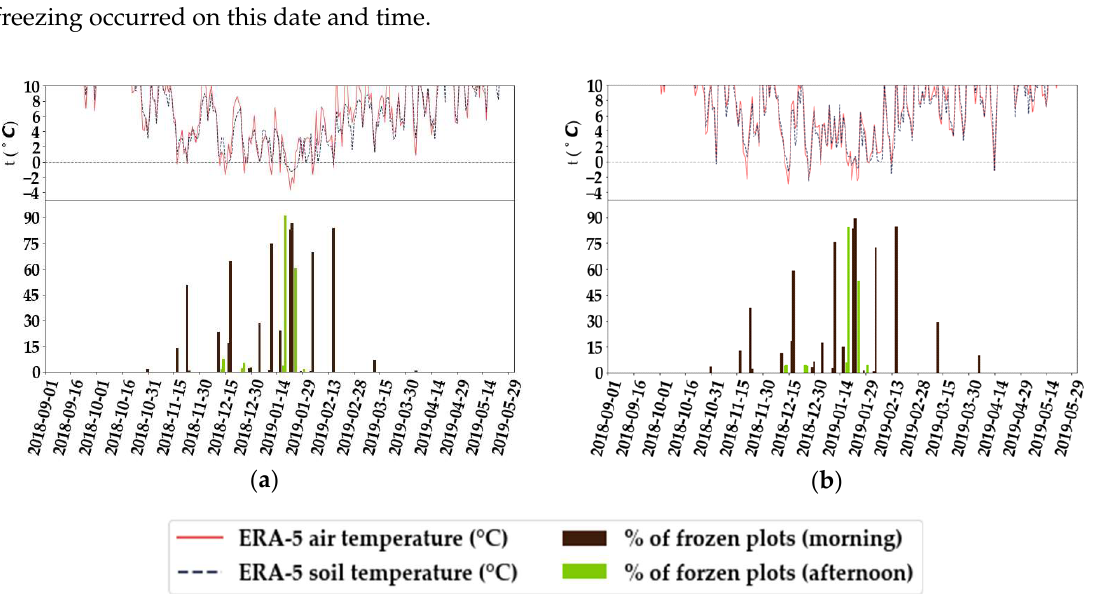
Figure 13. The distribution of frozen plots in site A in comparison to ERA5-Land’s soil and air temperatures at each S1 acquisition, and using VH and VV polarizations after applying the temperature filter. ( a ) VH, and ( b ) VV.